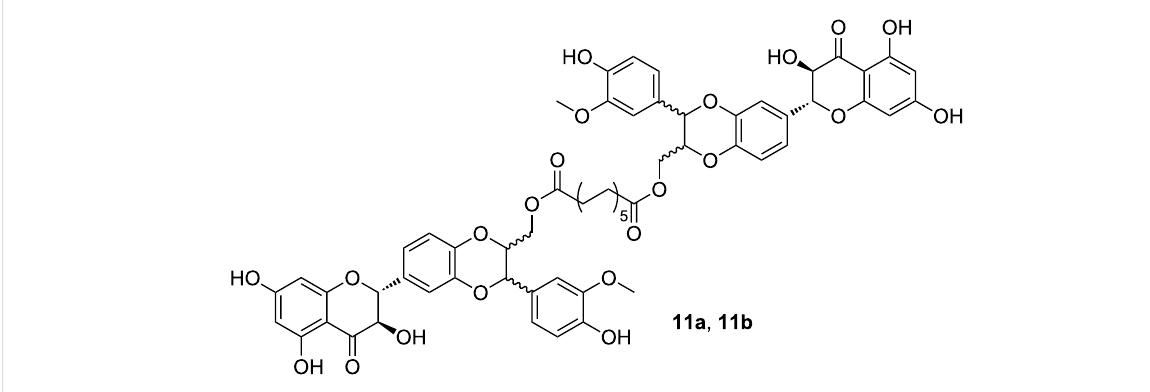
Figure 3: Sylibin dimers obtained by CAL-B catalyzed trans-acylation reactions.